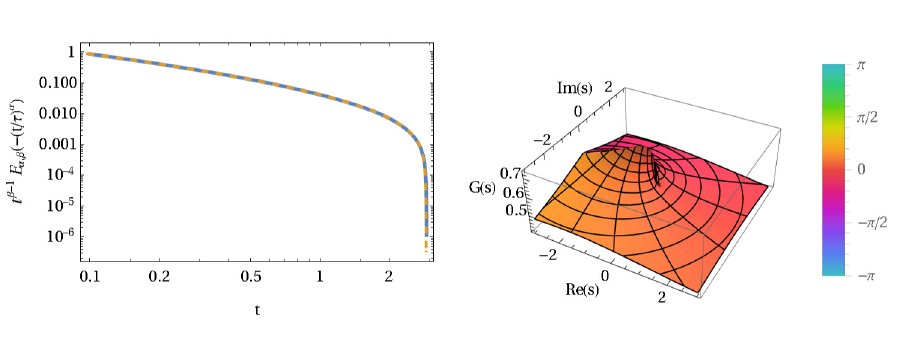
Figure 13. An example where the condition α < β is violated. Parameters are χ 0 = 1, τ = 1, α = 1/2, and β = 7/20. The pole of the transfer function is replaced by a singularity at zero (right